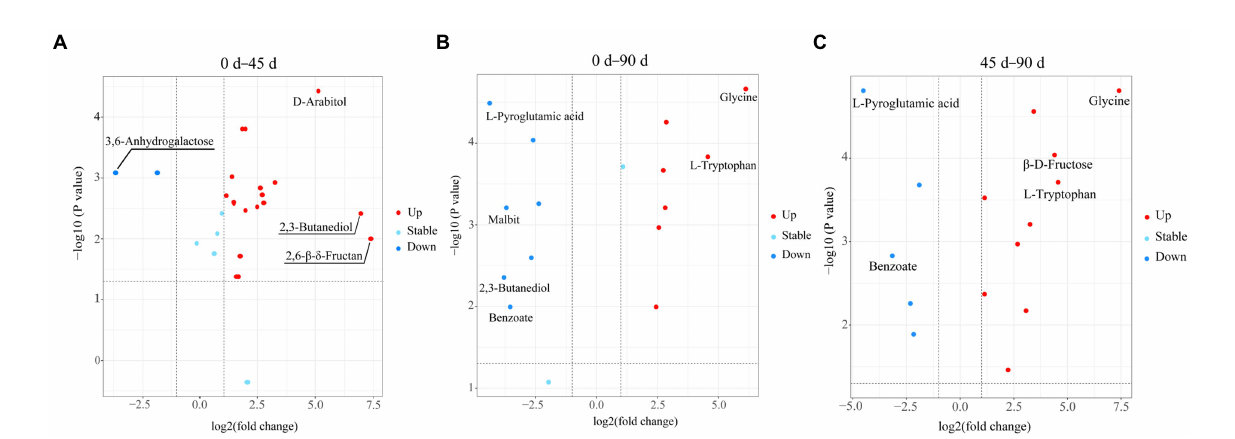
FIGURE 3 Volcano diagram of the differential metabolites in LSCKs fermented for 0, 45, and 90 days (A–C) , respectively, represents group A1 (0–45 days), A2 (45– 90 days), and A3 (0–90 days); blue and red, respectively, indicates the down − regulated and up − regulated differential metabolites.